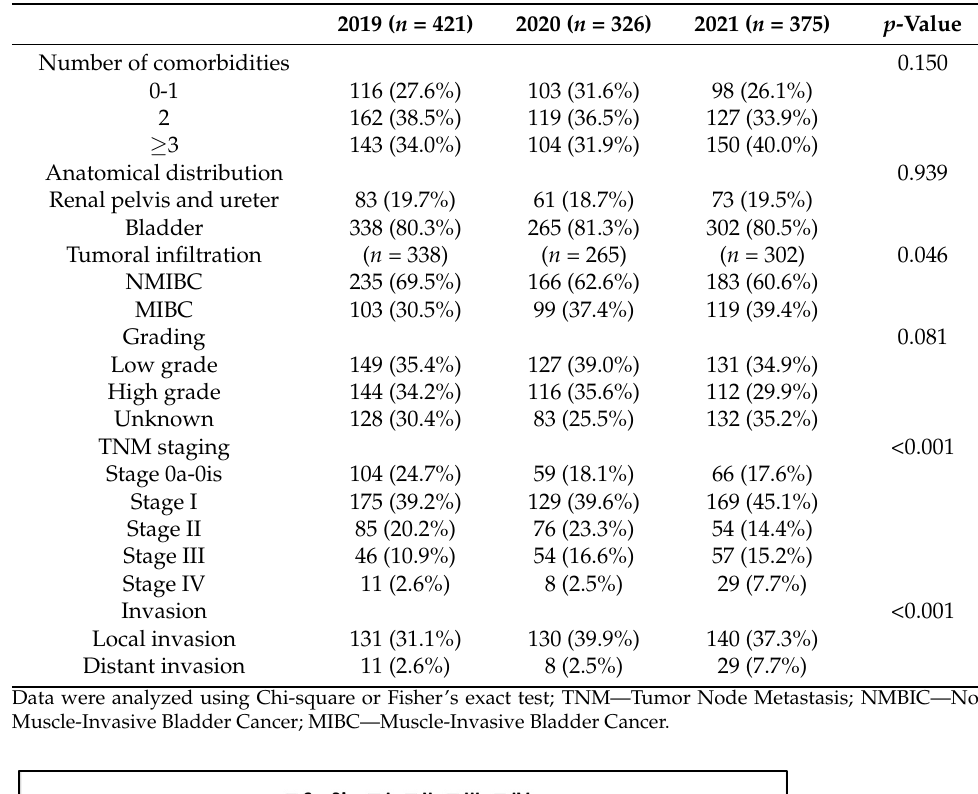
Table 2. Comparison of urothelial cancer characteristics during the study period.